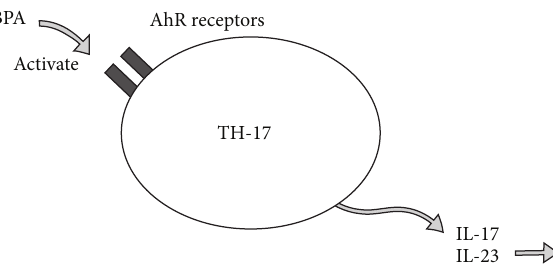
Figure 12: This diagram illustrates how bisphenol A can activate autoimmunity by inducing mRNA expression on aryl hydrocarbon receptors on TH-17 cells. AhR: aryl hydrocarbon; BPA: bisphenol A; IL: interleukin; TH: T-helper.